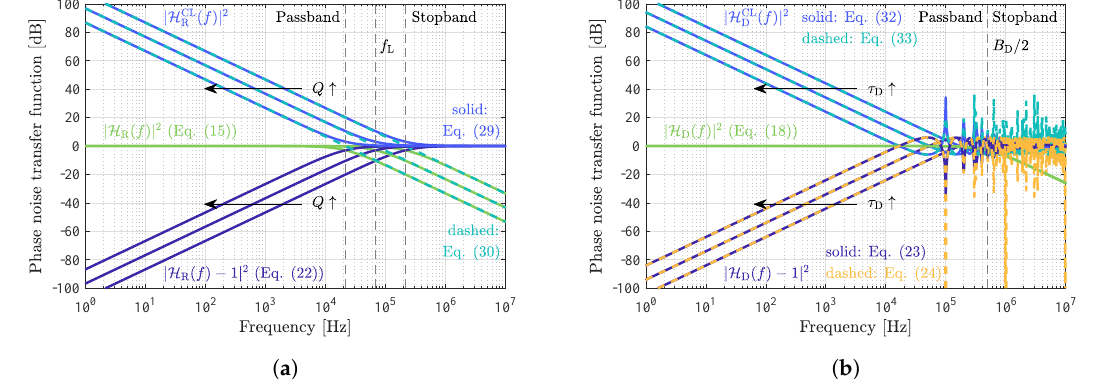
Figure 5. Progression of the calculated phase noise transfer functions in open-loop and closed-loop sensor systems for various quality factors Q of a resonant sensor ( a ) and various delay times τ D of a delay line sensor ( b ). The chosen sensor parameters are f R = f D = 434MHz, Q = { 1000,3162,10,000 } , B D = 1MHz, and τ D = { 1 µ s,3.162 µ s,10 µ s } . ( a ) Resonant sensor; ( b ) delay line